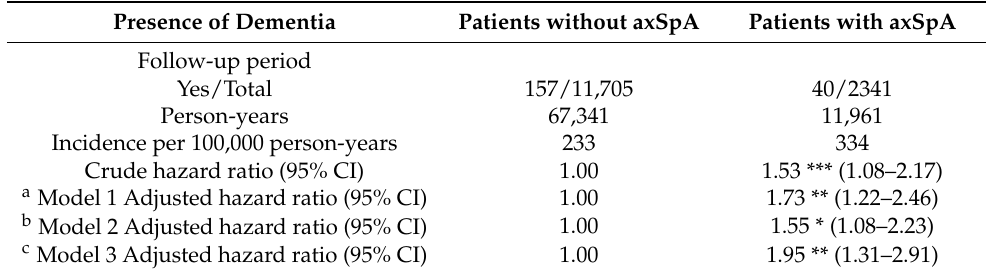
Table 2. Incidence and hazard ratio for dementia between patients with and without axSpA during the 7-year follow-up ( n = 14,046).